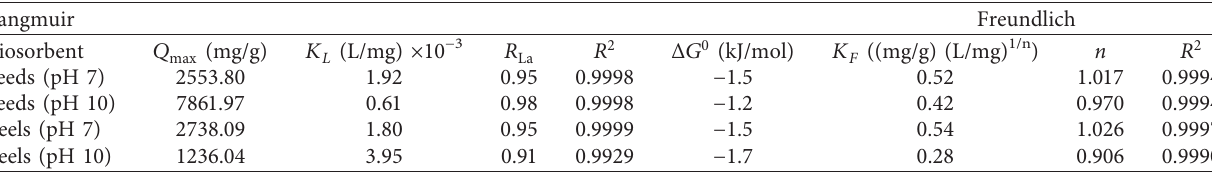
Table 2: Constants for Langmuir and Freundlich isotherms corresponding to nance seeds and peels at pH 7 and 10. Langmuir Freundlich